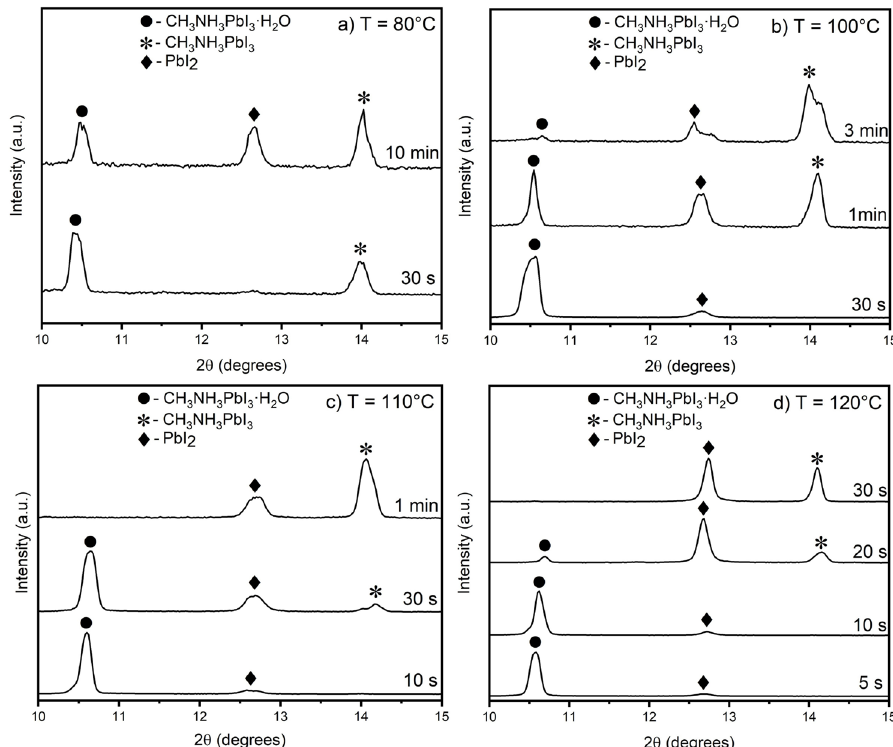
Figure 5. XRD patterns of the perovskite 50-day films fabricated via spray deposition at different temperatures and annealing times: a) 80 o C; b) 100 o C; c) 110 o C; d) 120 o C.